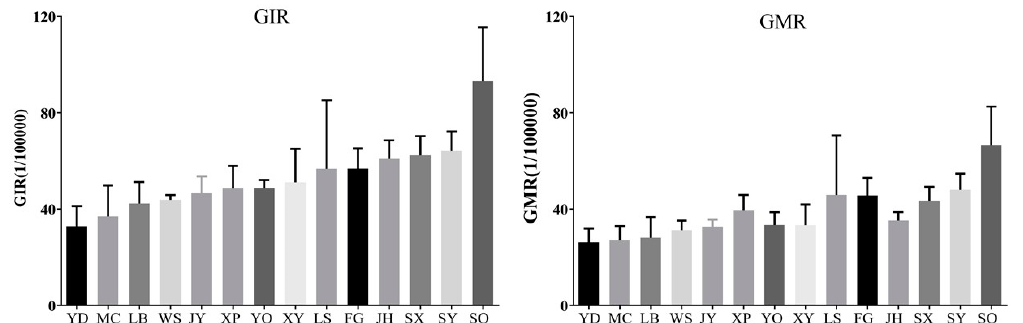
Figure 2. GIR and GMR values from 2014 to 2018.